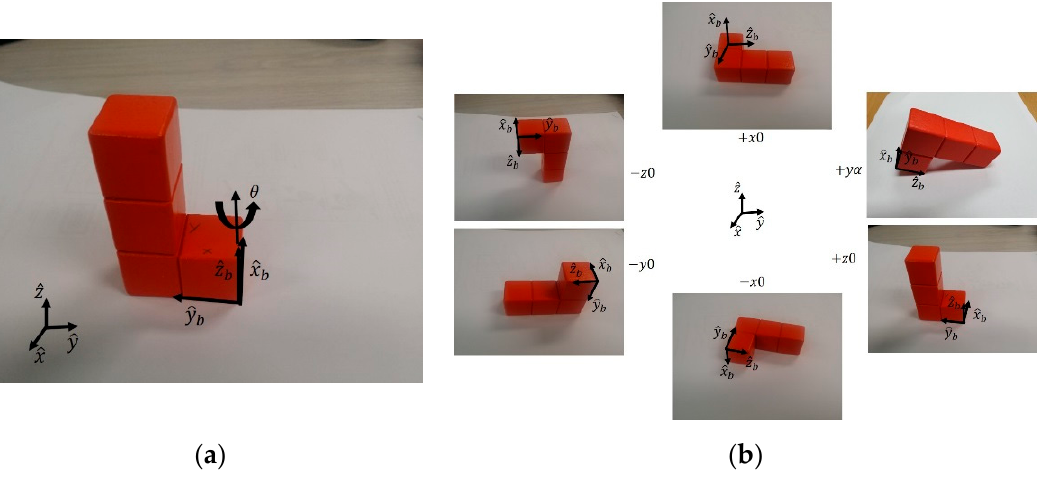
Figure 2. Part Orientation family example. ( a ) The local frame attached to part is represented with unit vectors (cid:4668)𝑥(cid:3548) (cid:3029) , 𝑦(cid:3548) (cid:3029) , 𝑧̂ (cid:3029) (cid:4669) . The orientation of part is represented with respect to the inertial frame (cid:4668)𝑥(cid:3548), 𝑦(cid:3548), 𝑧̂(cid:4669) . If the part is rotated about the 𝑧̂ axis by any angle 𝜃 , the 𝑧̂ (cid:3029) will have same orientation with respect to 𝑧̂ axis and the resulting pose will also be stable. ( b ) Different stable orientation families are represented. In each orientation family, one of the body frame axis has constant angle with 𝑧̂ of inertial frame.